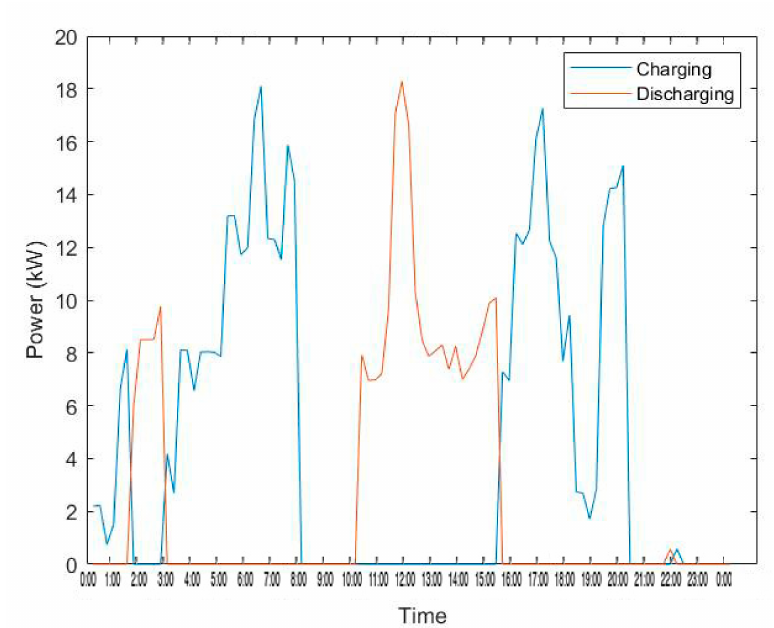
Figure 14. Charging and Discharging of Street Battery in Faulty Grid.